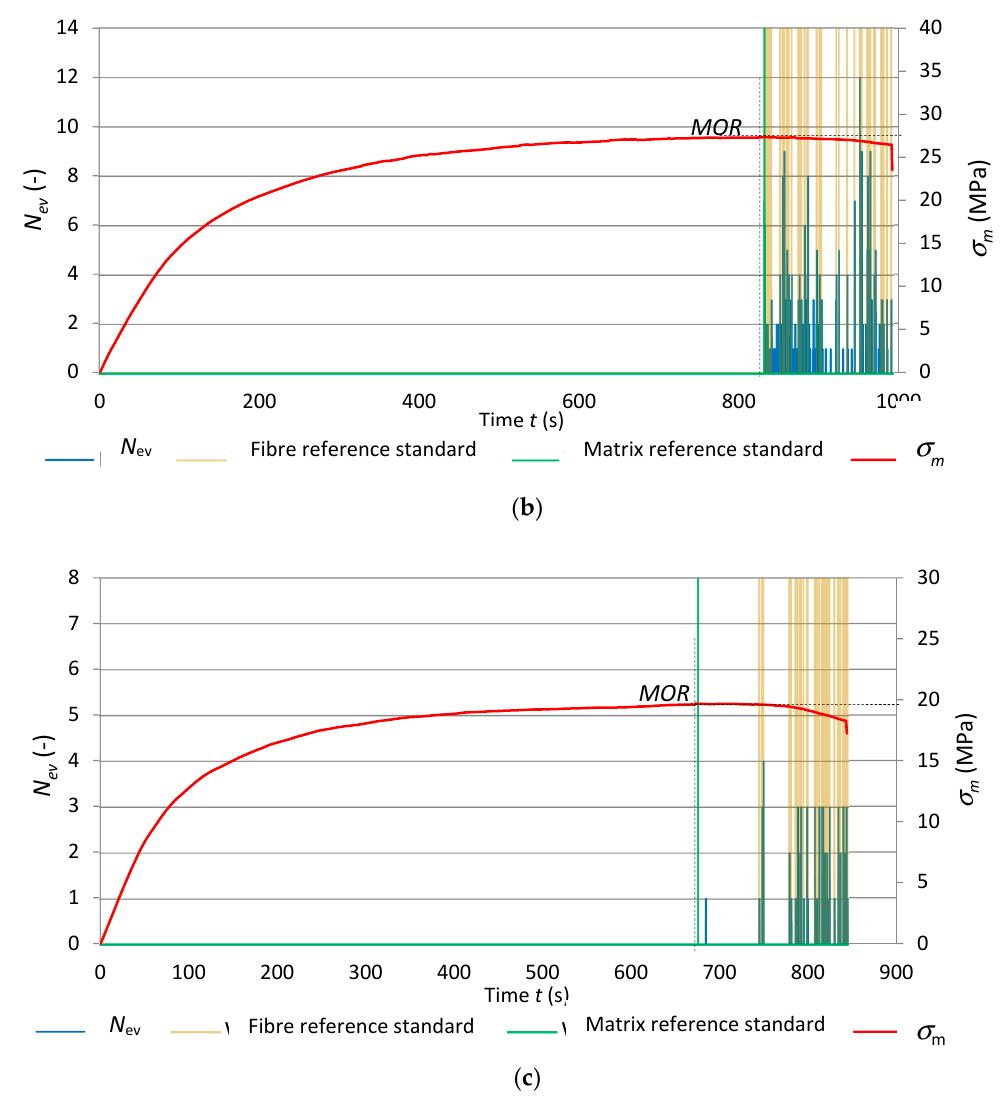
Figure 11. Events rate N ev and flexural stress σ m versus time, under freeze–thaw cycling, with superimposed identified reference spectral characteristics for: ( a ) series B R , ( b ) series B 1 , ( c ) series B 10 .